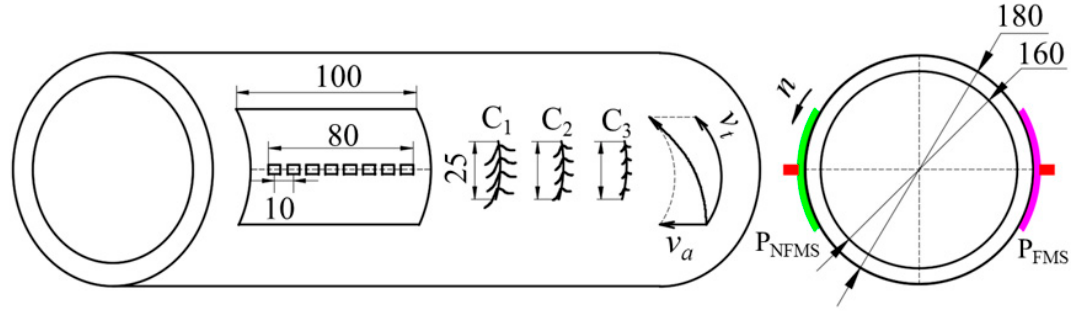
Figure 7. The MFL peak-to-peak amplitudes at different lift-off distances with different magnetization current densities.